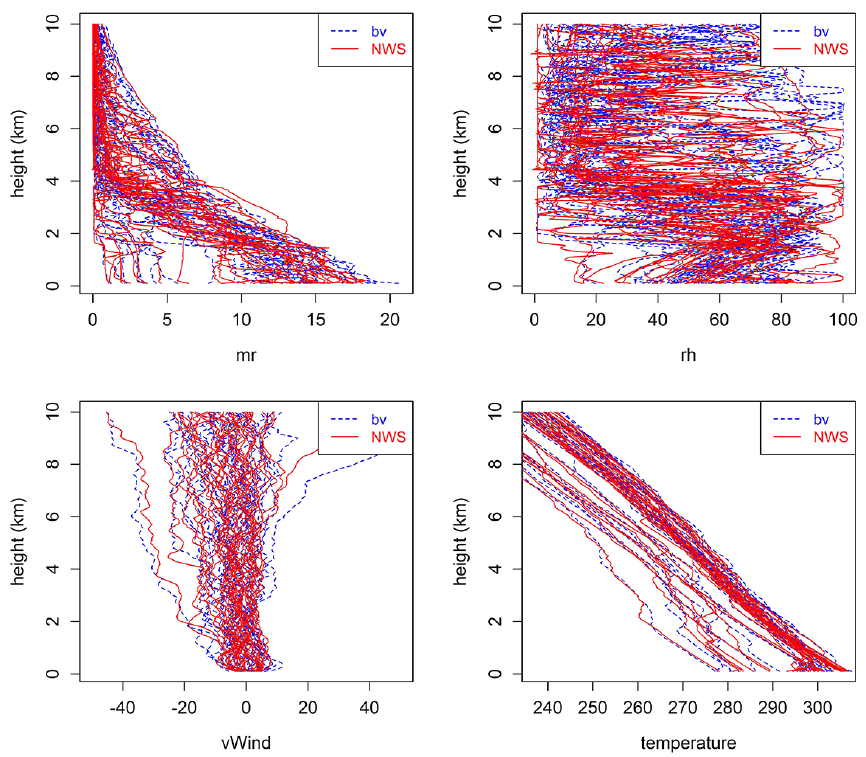
Figure 3. Thermodynamic profiles (µ) in Beltsville (BV) and Sterling (NWS). Top left: mixing ratio (mr); top right: relative humidity (rh); bottom left: east–west wind component ( v Wind); bottom right: temperature ( T